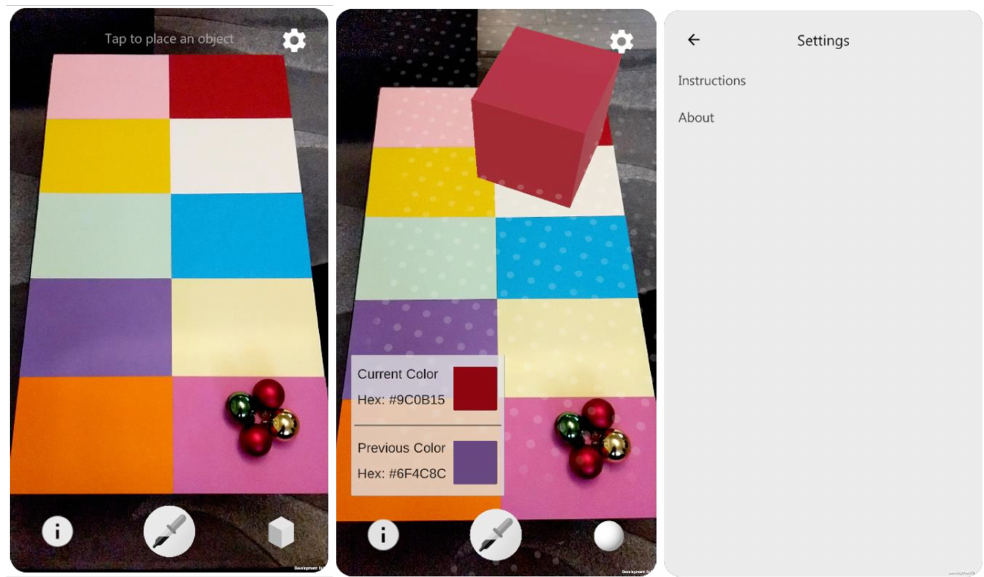
Figure 3. Functional range of the colAR